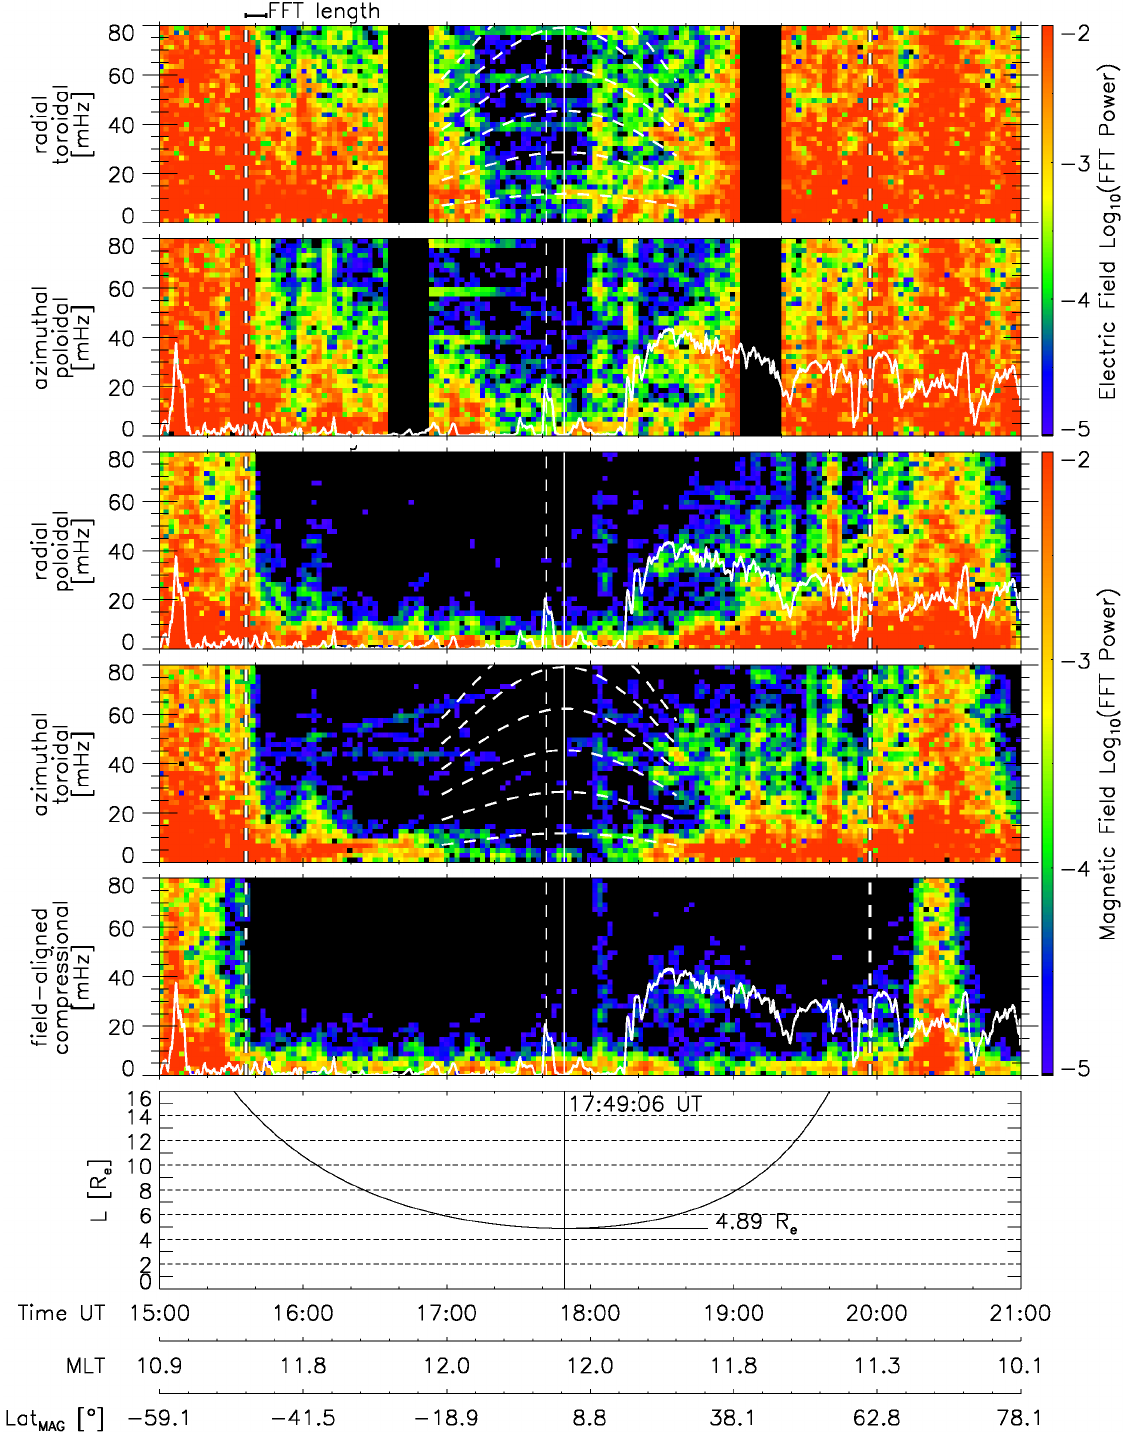
Fig. 4. Dynamic spectra of the radial, azimuthal electric and radial, azimuthal, field aligned magnetic field components measured by s/c 1 on 05 September 2002. The vertical dashed lines give the times of the inbound and outbound OCB crossings. The expected frequencies of the Alfv´enic toroidal mode have been overplotted in the radial electric and azimuthal magnetic panels as white dashed lines. The frequency of upstream generated waves as predicted by Eqn. 1 is overplotted on all other dynamic spectra. The bottom panel shows the L values of the crossed field lines. The minimum L value and the time it was reached are marked by a solid vertical line. The time of crossing the magnetic equator is given by a thin white dashed line. Additional x axes give MLT and magnetic latitude.